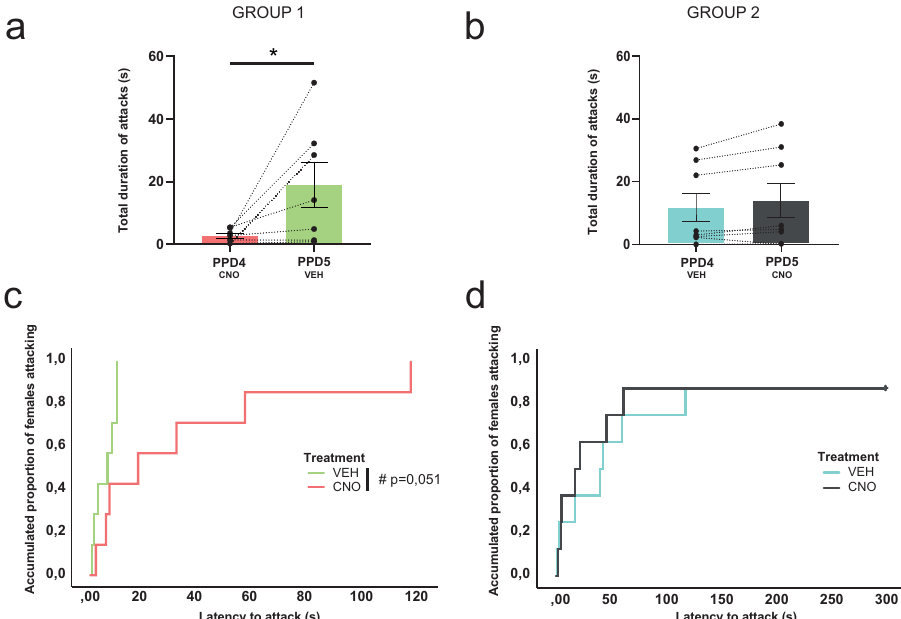
Fig. 4 Inhibition of MeA did not block maternal aggression but prevented its increase during the second day of testing. In Group 1, injected with CNO in PPD4 and VEH in PPD5, the ANOVA showed signi fi cant differences between PPD4 and PPD5, with an increase in the total duration of aggression during the second session of testing ( a ) and a trend towards a decrease in latency to attack on the second day of testing ( c ). For Group 2, injected with Veh in PPD4 and CNO in PPD5, the ANOVA did not reveal signi fi cant differences between studied days in the total amount of time ( b ) or the latency to attack ( d ). Data are represented as mean ± SEM; * p ≤ 0.05, # p = 0.051. CNO clozapine N-oxide, Veh periods, on PPD3, PPD7, PPD11, PPD15 and PPD19. They